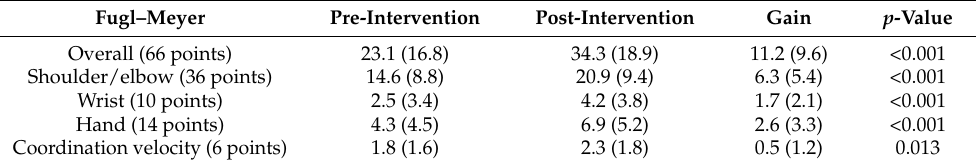
Table 2. Clinical outcome.